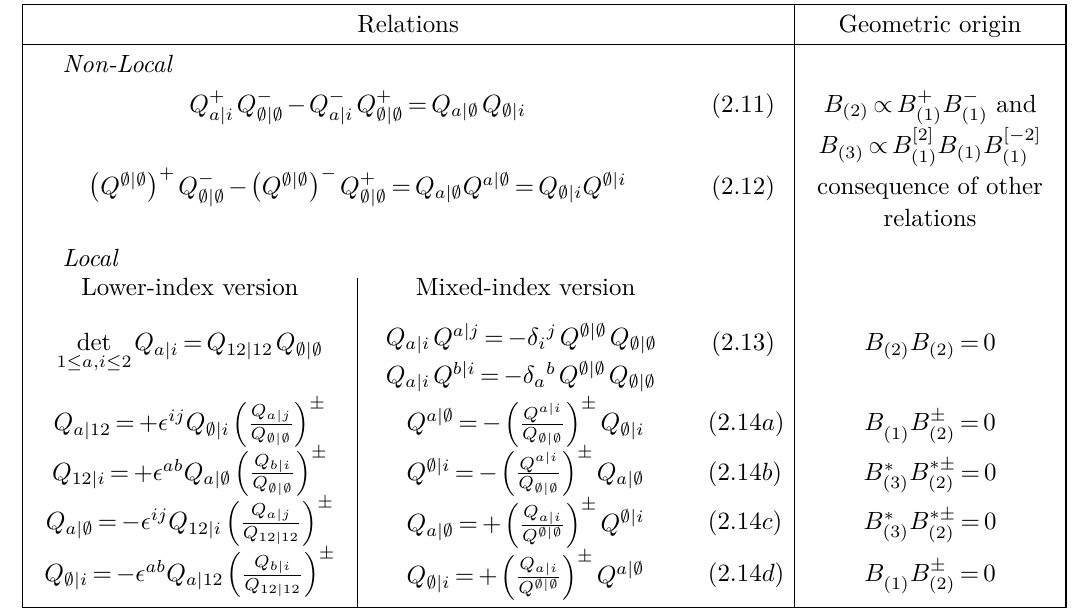
B + = 0 means that the line defined by B (1) (2) etc; B ∗ denotes a Hodge-dual (2)